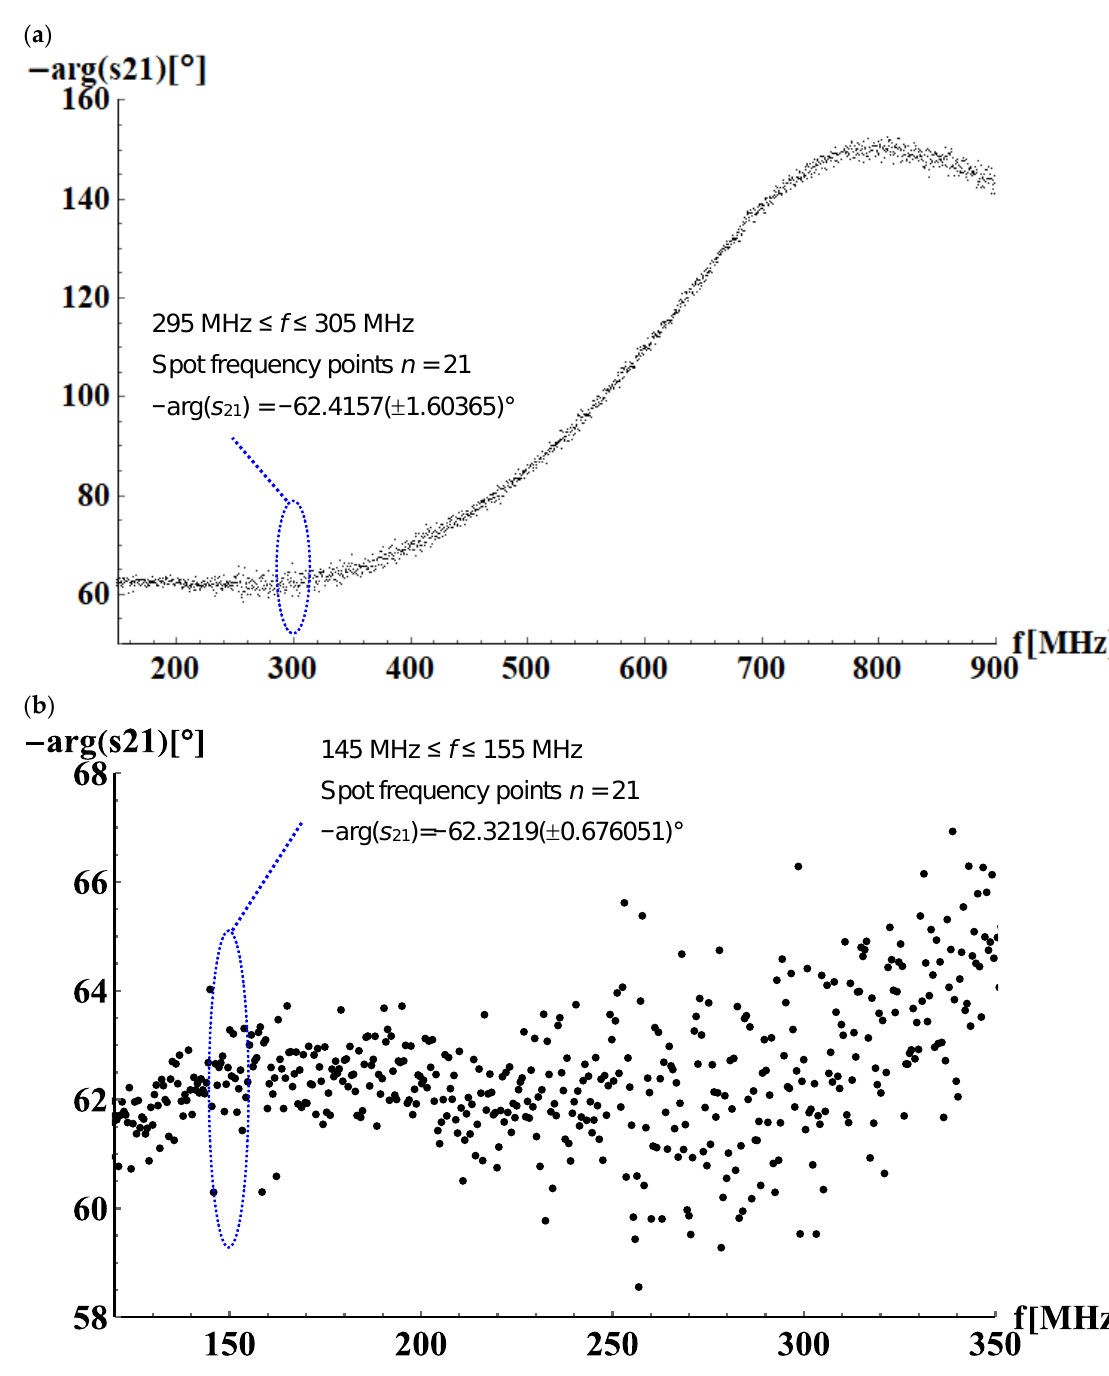
Figure 5. The direct measurement of the wave transmission through the MEMS test structure (s 21 ) for ( a ) 150 MHz ≤ f ≤ 900 MHz and ( b ) 150 MHz ≤ f ≤ 900 MHz.